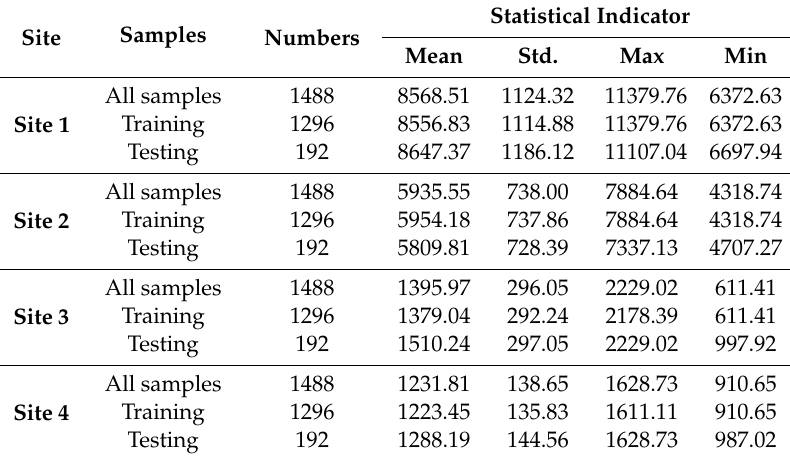
Table 2. Structure of four selected datasets in Australia.